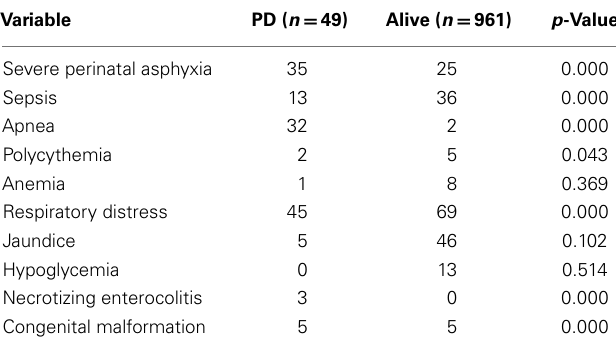
Table 7 | Neonatal morbidities association with perinatal deaths